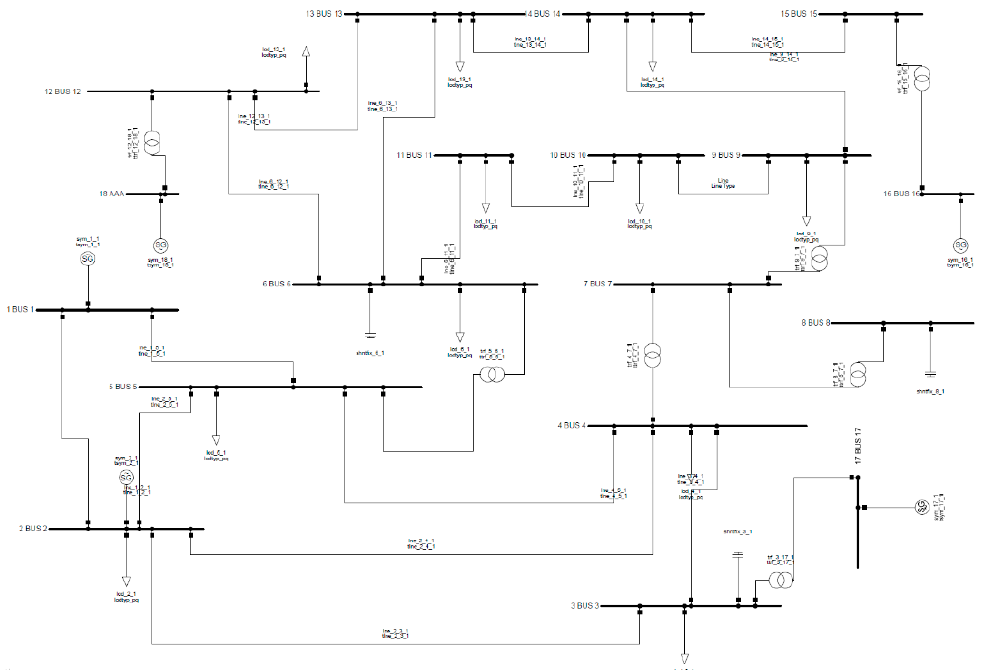
Figure A1. Modified IEEE 18-bus test system based on PowerFactory.